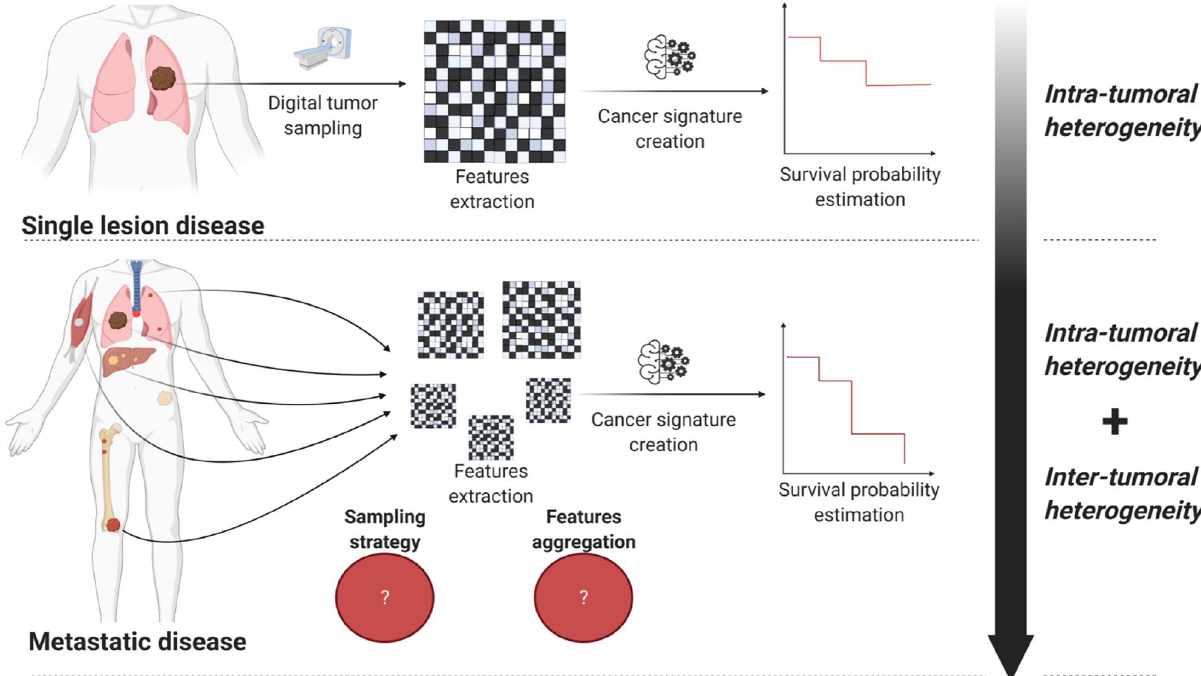
Figure 1. Radiomic analysis strategy: from one lesion radiomics to metastatic disease data extraction. While the analysis pipeline for single lesion disease is now described, the metastatic disease pipeline still has some grey areas: first there is no existent guidelines for the sampling strategies of tumors (which one? how many?), and second, there is no consensus on how to aggregate the extracted features for further analysis. Indeed, the number of lesions delineated per patient could vary, and the downstream machine learning pipeline used for single lesion analysis cannot be reused «as-is». Created with